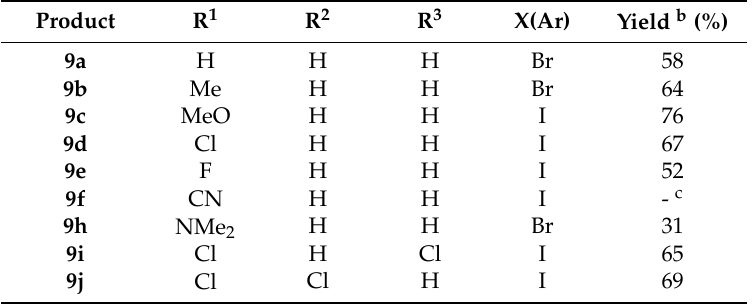
Table 3. Chemical structures and yields obtained for the synthesis a of series 9a – j (R 1 , R 2 , and R 3 ). Product